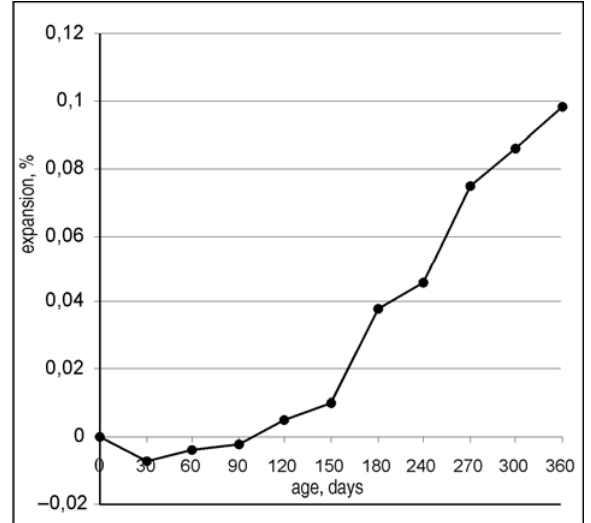
Fig 4. Expansion of concrete prism with quartzitic sand- stone in the ASTM C 1293 test